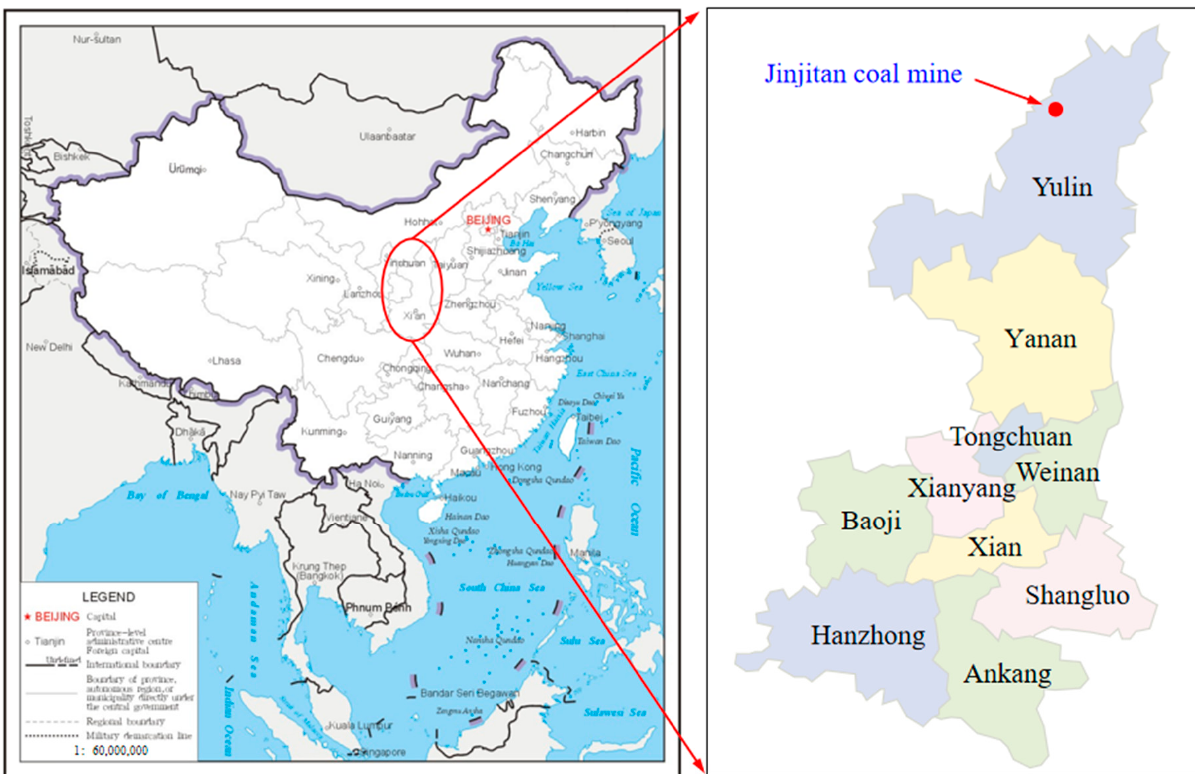
Figure 3. Location map of Jinjitan coal mine.